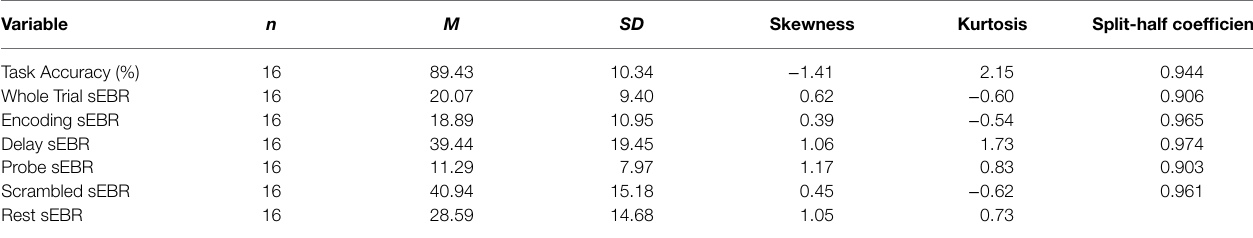
TABLE 1 | Descriptive statistics and split-half reliability for Experiment 1. Variable n M SD Skewness Kurtosis Task Accuracy